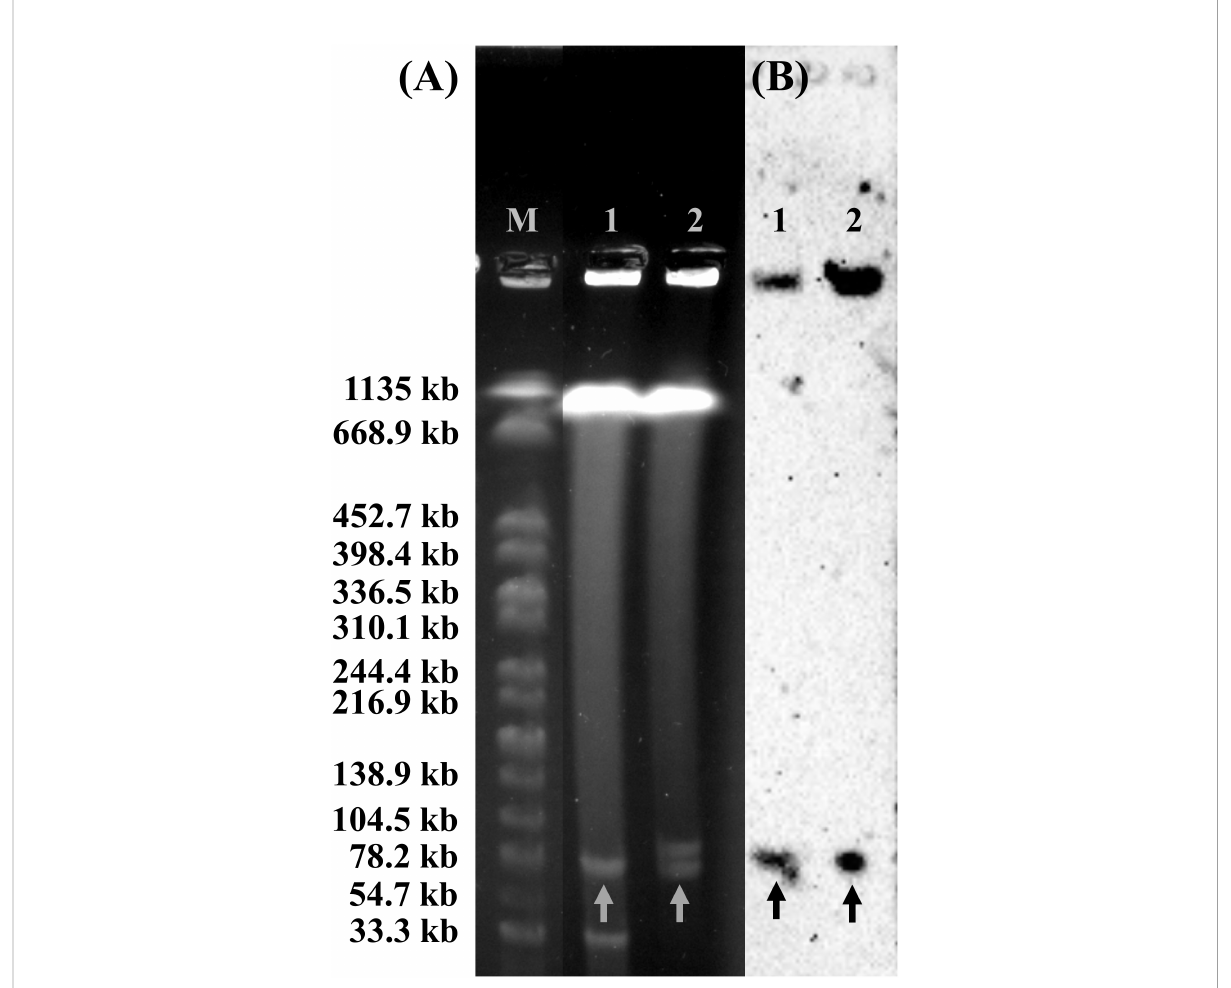
FIGURE 5 Plasmid pro fi le analysis of Citrobacter isolates harboring mcr-3.5 gene by S1-PFGE and DNA hybridization. (A) The pro fi le of total DNA treated with S1 nuclease and (B) relative hybridization of mcr-3 probe. Lane M, molecular standard, which is Salmonella braenderup H9812 digested with Xba I. Lane 1, Citrobacter amalonaticus strain SY-CA35. Lane 2, Citrobacter sedlakii strain SY-CS04. Arrows indicate the locations of plasmid harboring mcr-3